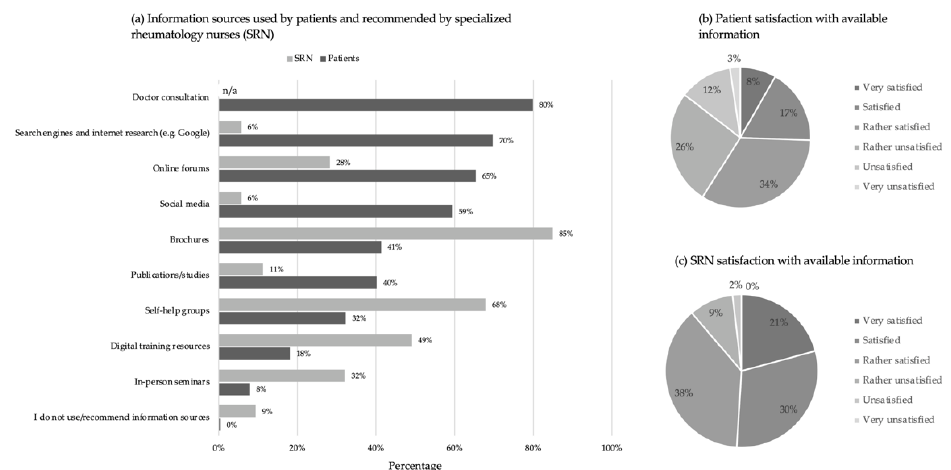
Figure 1. Information sources used by patients and recommended by specialized rheumatology nurses (SRN) and satisfaction with the currently available information. ( a – c ) Data is displayed as the percentage of total patients and SRN that responded to the question.